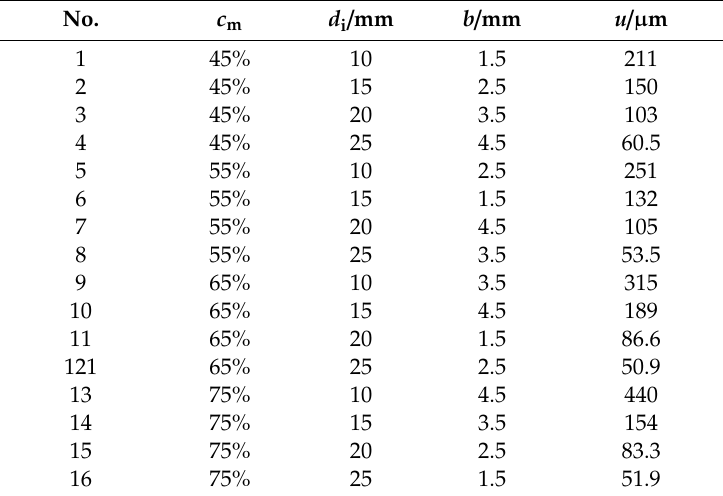
Table 6. Samples for the Kriging model.